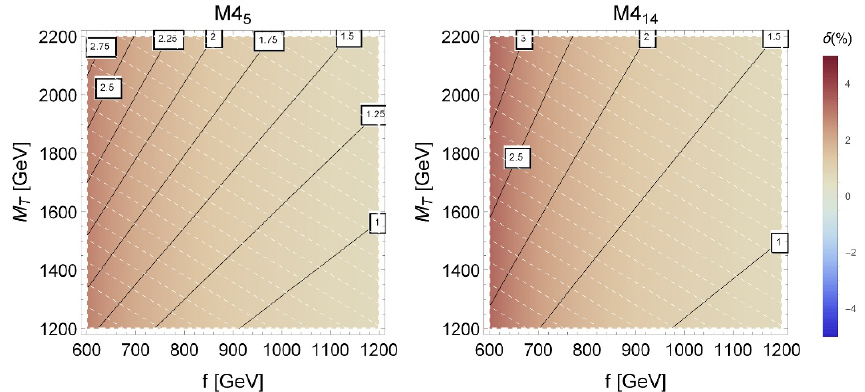
Figure 14 . The contour plots of the contribution to (cid:14) with sin 2 (cid:18) R = 0 : 4 and p cut each of the fourplet models with one top partner multiplet. In this (cid:12)gure, we take into account only the CP-odd Yukawa coupling. The corresponding values of y are indicated by the solid lines. As indicated by the dashed white lines, all points on these plots result in (cid:20) t (cid:20) 0 : 8.